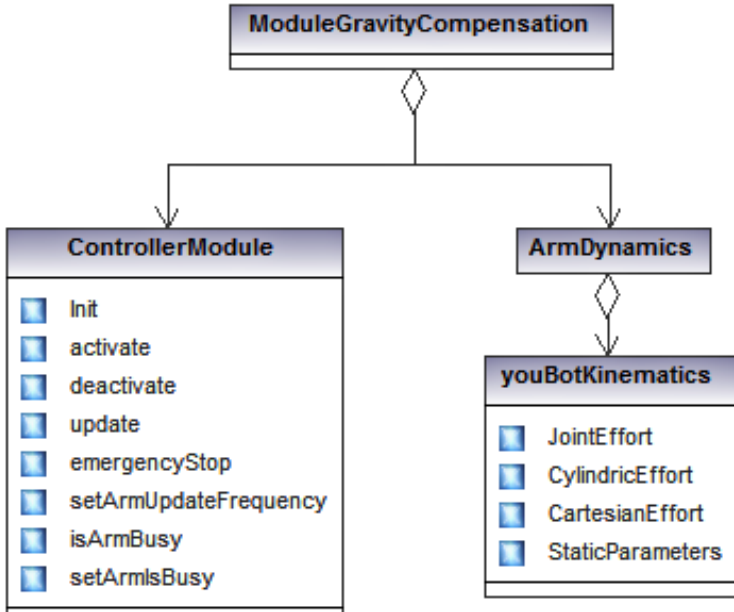
Figure 11. Gravitational Compensation class